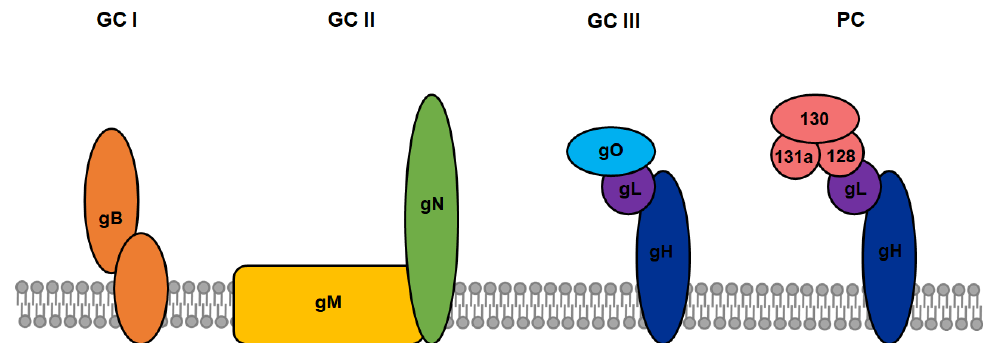
Figure 2. Various types of glycoprotein complexes on the surface of HCMV and the host cells. The viral surface is clustered with various heterogeneous CMV glycoprotein (g) complexes (GC), including of the oligomer gB (GC I), the heterodimer gN/gM (GC II), the heterotrimer gH/gL/gO (GC III), and the so-called pentameric complex (PC) comprised of gH/gL/UL128/UL130/UL131a.